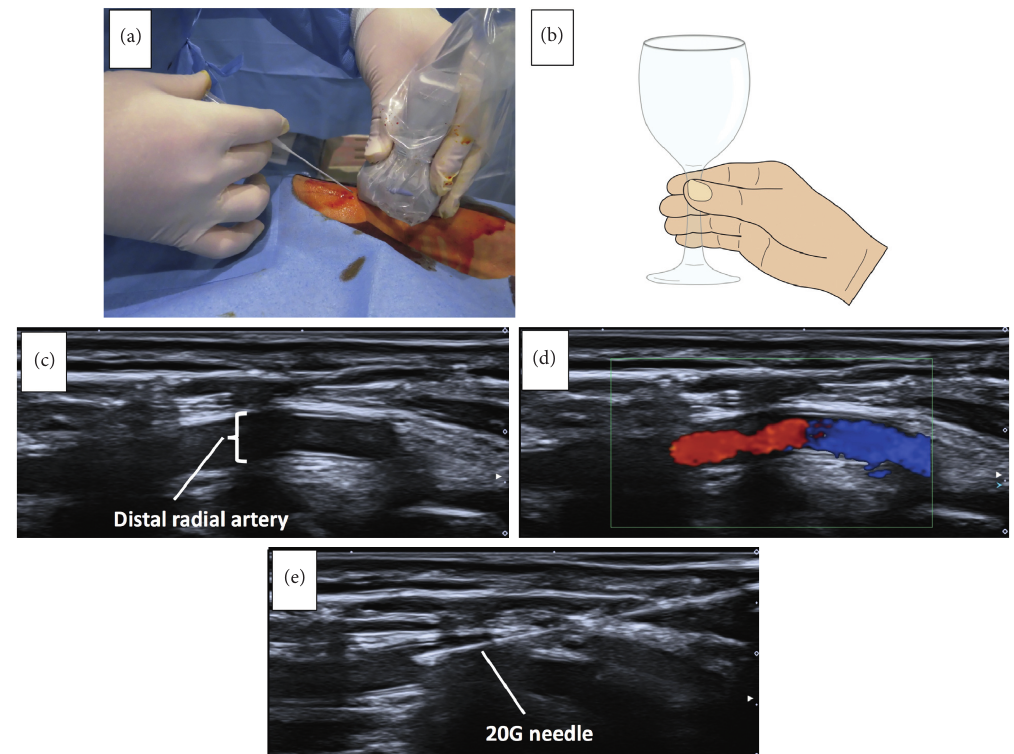
Figure 2: (a) A puncture with a 20G needle under the long-axis ultrasound guidance. (b) The way of using the patient’s hand that has a wineglass makes us puncture under ultrasound guidance easily. (c) Long-axis ultrasound shows the distal radial artery. (d) The Doppler- ultrasound shows the blood flow in the radial artery. (e) Ultrasound shows the puncture with a 20G